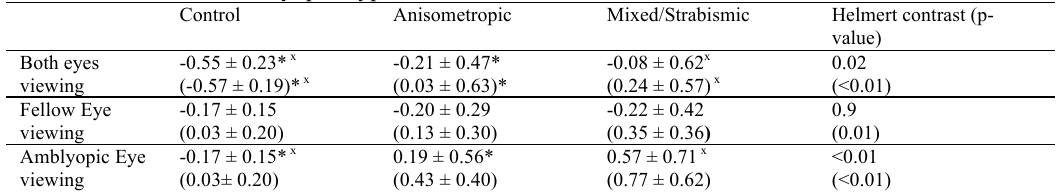
Both eyes viewing: top row: fellow eye, bottom row with parenthesis = amblyopic eye Fellow and Amblyopic eye viewing: top row: viewing eye, bottom row: non-viewing eye * = statistically significant values for planned contrast between controls and anisometropic amblyopia, x =statistically significant values for planned contrast between controls and strabismic/mixed amblyopia